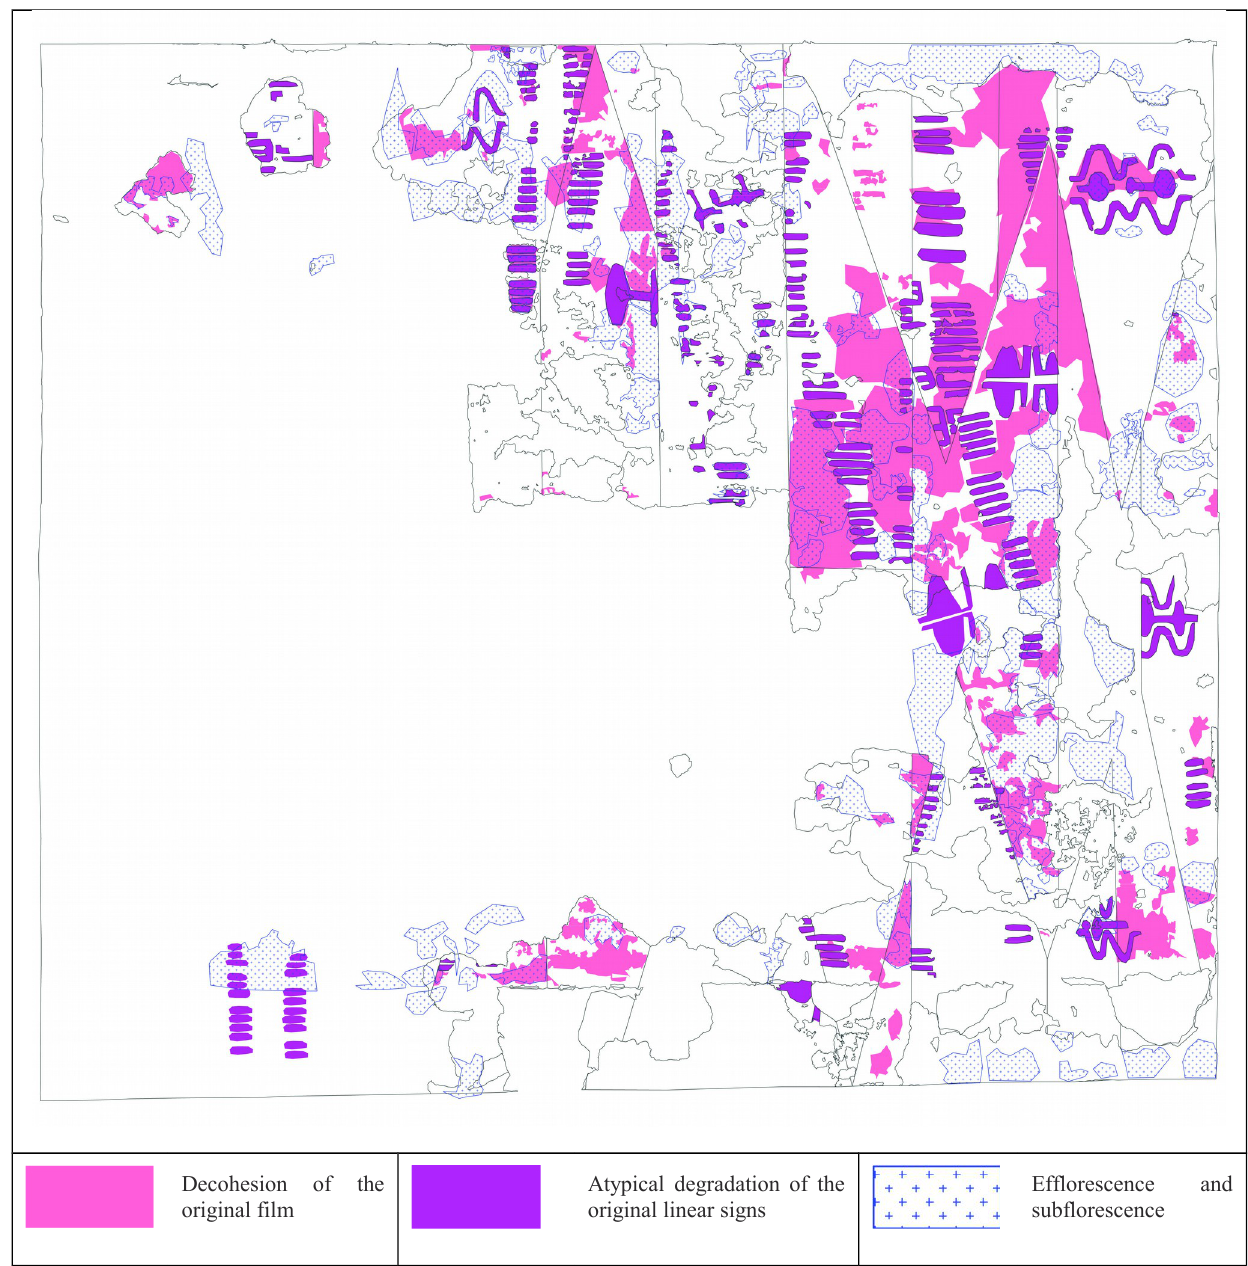
Figure 5 . Thematic graphic table of the State of Conservation (C) and its legend. Image: Paola Mezzadri all rights